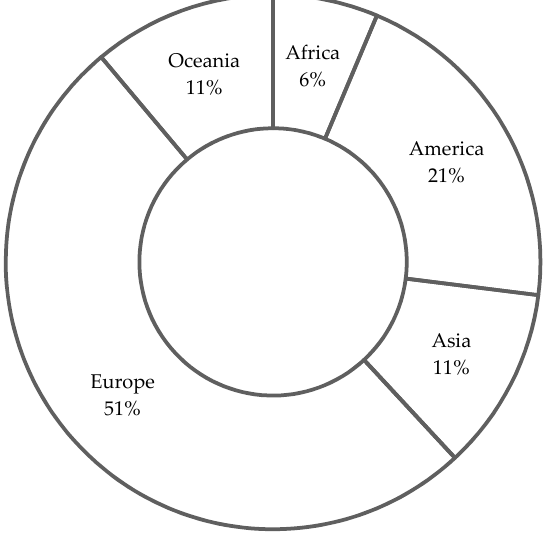
Figure 7. Productivity by world region.